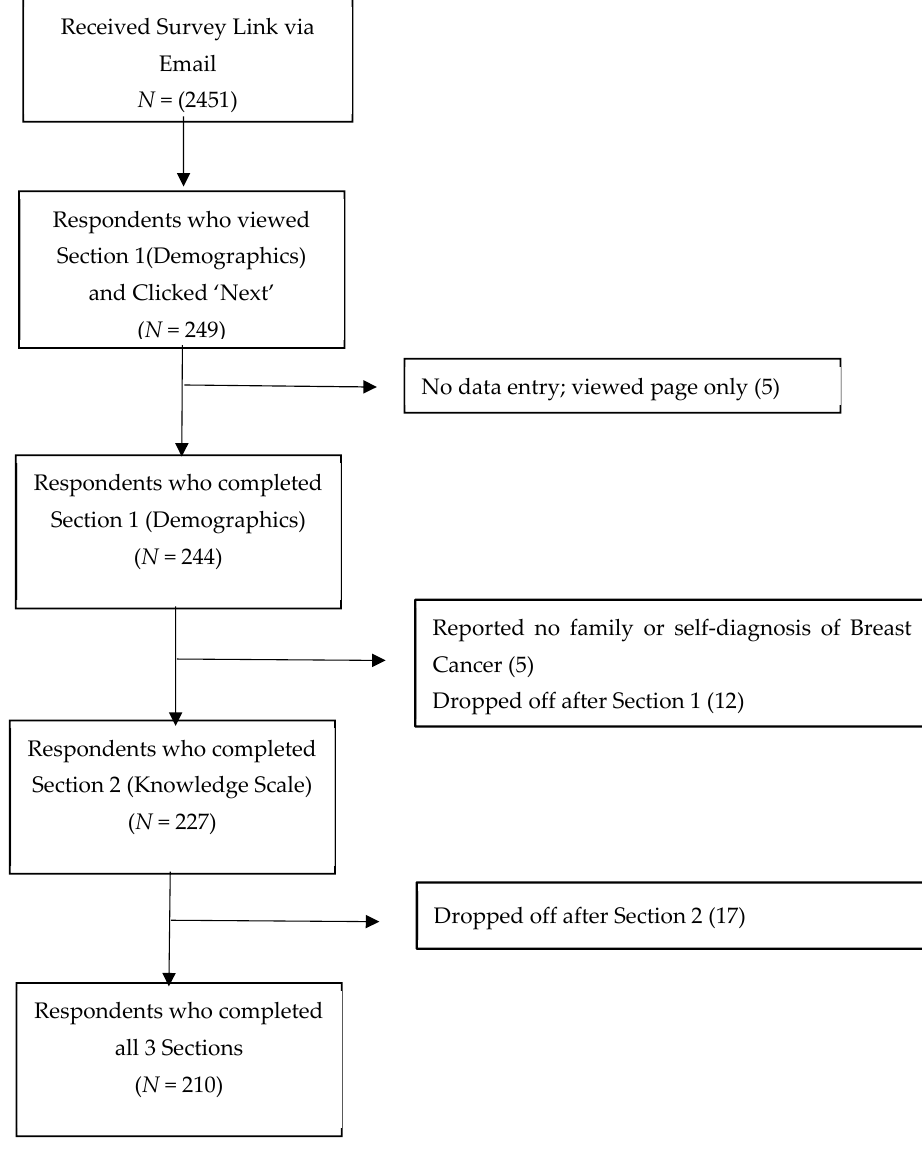
Figure 1. Study Flow Diagram. Table 1. Self-reported demographics and breast cancer-specific characteristics ( N = 244).